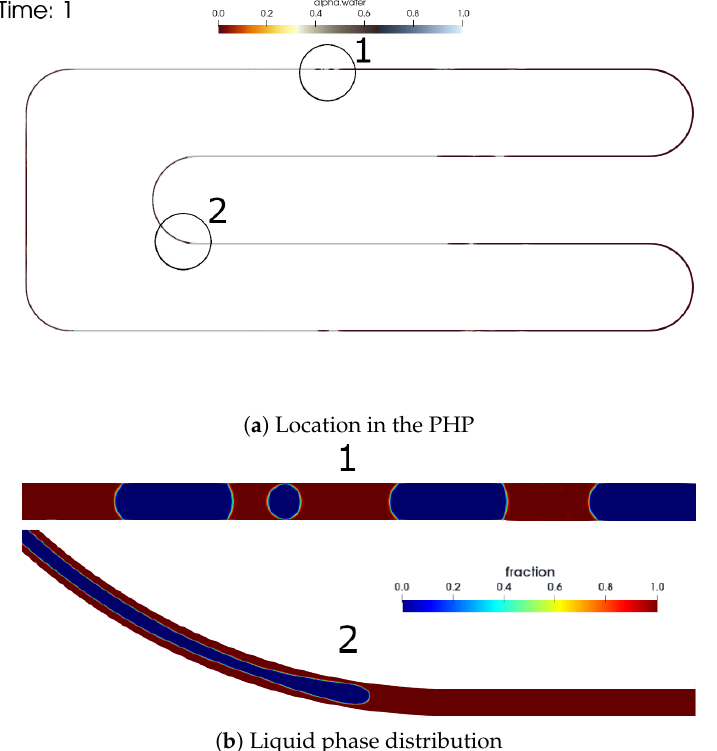
Figure 15. Numerical results of the Tanasawa model [26] in 1.0 s for 100 W input power.